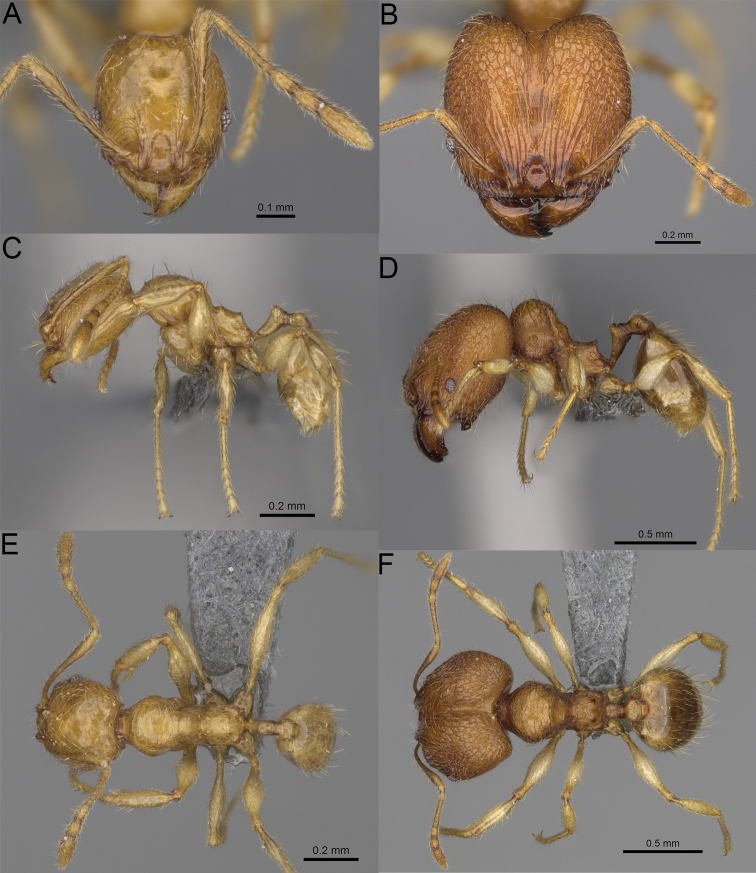
Pheidole
parvulogibba sp. nov., full-face view (A), profile (C), and dorsal view (E) of paratype minor worker (CASENT0923274) and full-face view (B), profile (D), and dorsal view (F) of holotype major worker (CASENT0704453).